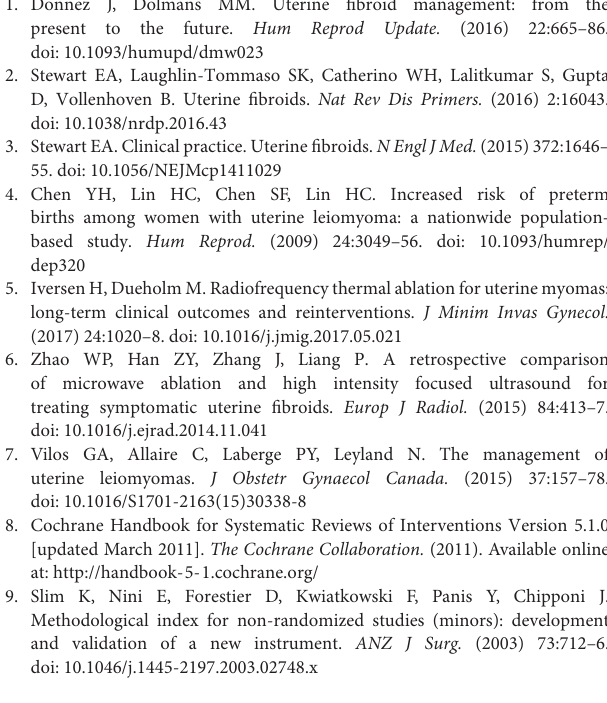
Supplementary Table 1 | Risk of bias of included randomized controlled trials. Supplementary Table 2 | Risk of bias of included non-randomized controlled trials. ∗ For outcomes which were included in the systematic review. The items were scored as 0 (not reported), 1 (reported but inadequate), or 2 (reported and adequate). Supplementary Table 3 | Risk of bias of included cohort studies. ∗ For outcomes which were included in the systematic review. # Study controlled for: number of fibroid tumors/volume of all fibroid tissues or the maximal fibroid diameter, and age of patients. A study could be awarded a maximum of one star for each numbered item within the “Selection” and “Outcome” categories, and a maximum of two stars could be given for “Comparability.” Supplementary Table 4 | GRADE evidence profile of the outcome of rate of re-intervention. 1. Cohort studies were assessed in accordance with the Newcastle-Ottawa Quality Assessment Scale (NOS), and the best quality of cohort studies should be those with nine stars. However, six stars were given to the three included studies. 2. The results from Barnard et al. (19), which only observed the short-term outcomes, did not find any statistical significant differences between HIFU and UAE. 3. Pooled odds ratio (OR) was 11.99 (95% confidence interval: 5.17–27.83, p < 0.001). 4. For Froeling et al. (13), volume of fibroid diameter and age at baseline were significantly higher ( p < 0.005) in the MR-HIFU group. 5. Cohort studies were assessed in accordance with the NOS, and the best quality of cohort studies should be those with nine stars. Eight, seven, and five stars were given to the three included studies. 6. The results from Chen et al. ( 20) and Mohr-Sasson et al. (27) did not find any statistical significant differences between high-intensity focused ultrasound (HIFU) and myomectomy (MYO). 7. Pooled OR was 4.05 (95% CI 1.82–8.99, p < 0.001). 8. In Chen et al. (20), the mean age of the HIFU group was lower than that of the surgery group, and the uterine volume was smaller. In Mohr-Sasson et al. (27), women in the laparoscopic MYO group were younger ( p < 0.001), and multiple uterine fibroid tumors were more common in the laparoscopic MYO group ( p <